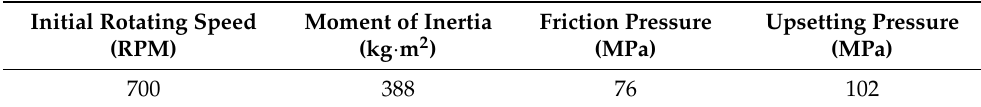
Table 2. Inertia friction welding parameters of TC21